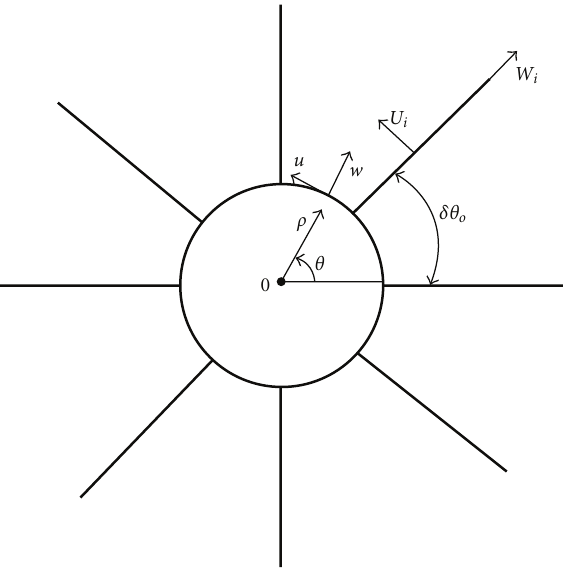
Figure 1: Schematic representation of a bladed